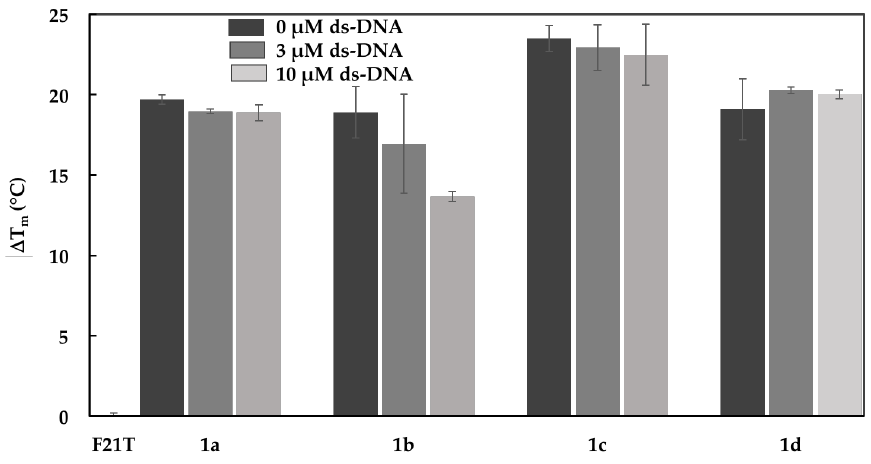
Figure 2. Stabilization of F21T (0.2 µM) by 1a – d (5 µM) in the presence of various concentrations of a double-stranded competitor, ds26. Comparison of ∆T m in K + conditions in the absence of competitor (black) vs. ∆T m in K + conditions in the presence of ds26 (grey bars). Error bars correspond to SD of at least three independent experiments. Experiments were performed in 10 mM lithium cacodylate buffer (pH 7.2), 90 mM LiCl, and 10 mM KCl. T m in absence of ligands of F21T is 52.4 ± 0.3 °C. The radar plot shown in Figure 3 and Table 3 show that compounds 1a – d are able to stabilize all the G4 forming sequences.